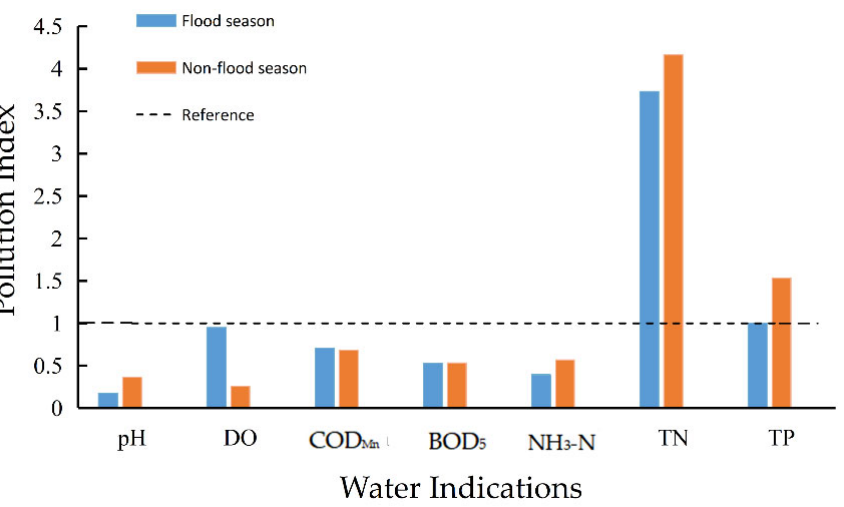
Figure 3. Distribution of single-factor pollution indices for water quality indicators in flood and non-flood periods.